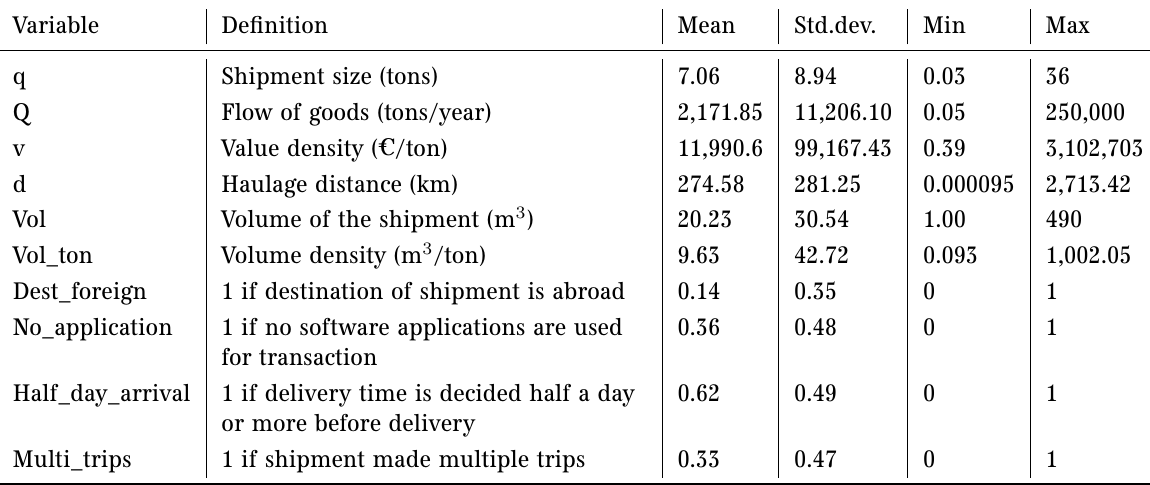
Table 1: Summary statistics of the TLC variables (2,219 observations).